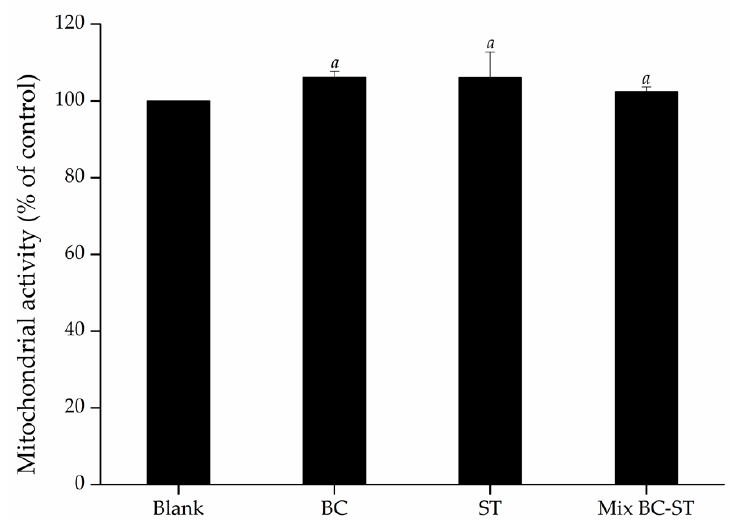
Figure 4. Mitochondrial activity (measured using MTT assay) of Caco-2 cells exposed to black carrot (BC), strawberry (ST) and their mixture (Mix BC-ST), expressed as % of control (no treatment). Different letters indicate significant differences.